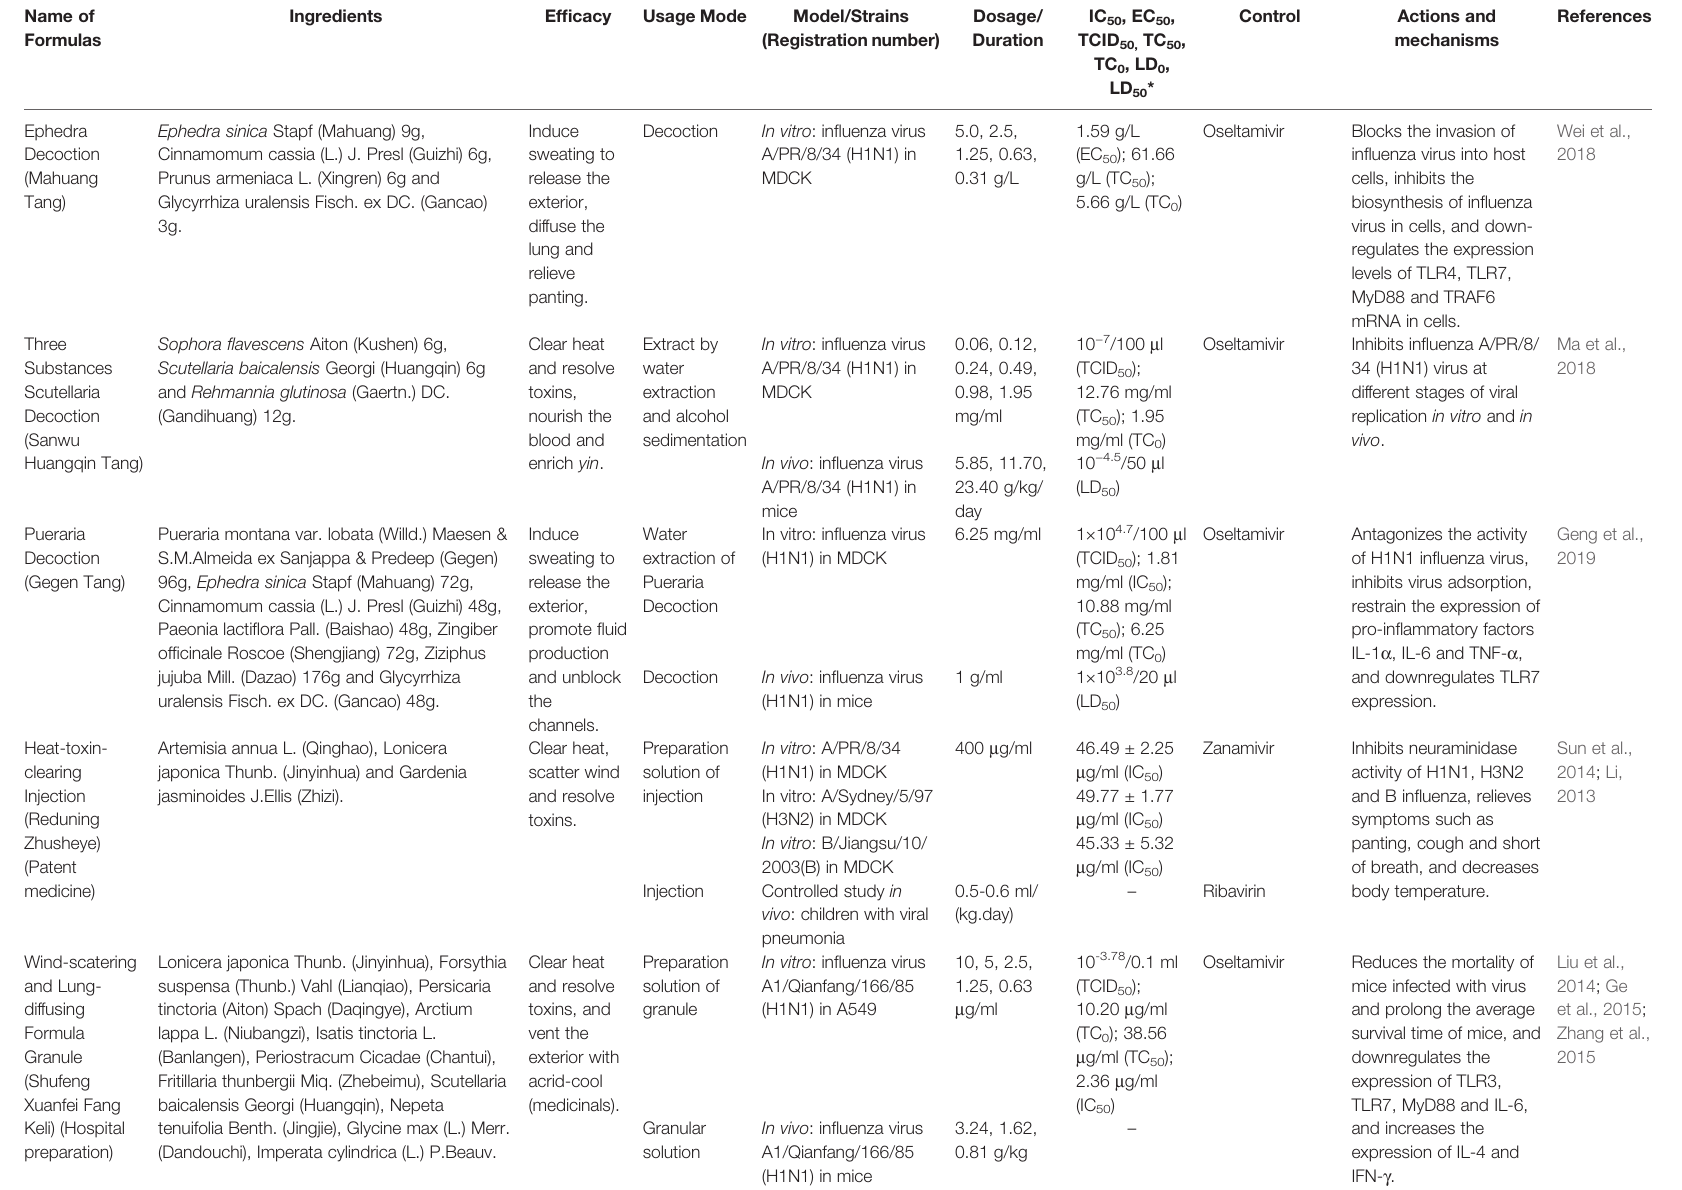
TABLE 2 | Effects and mechanisms of Chinese medical formulas on antiviral